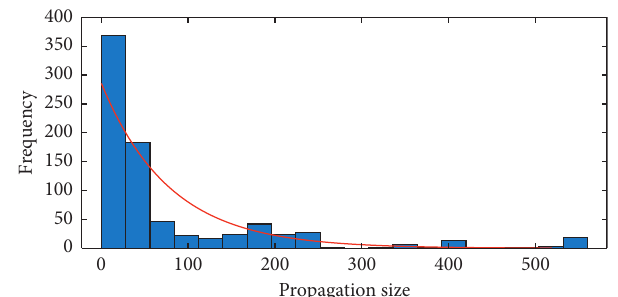
Figure 9: Distribution of propagation